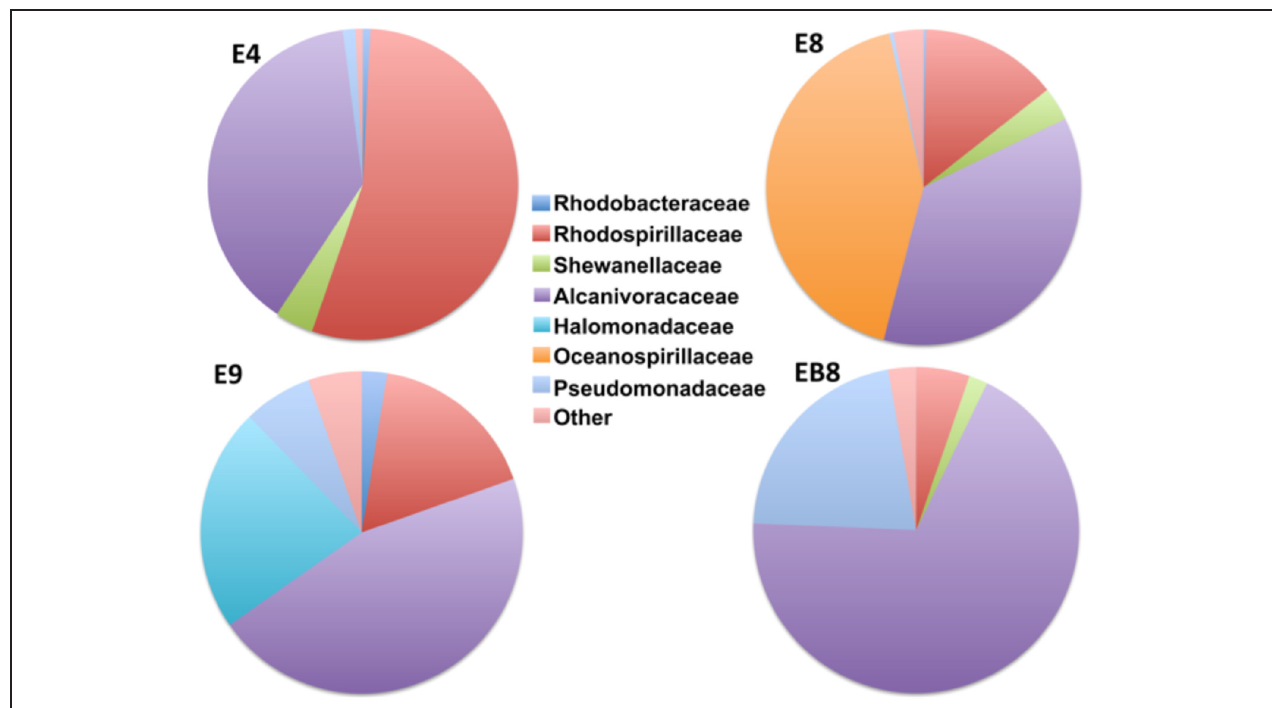
FIGURE 2 | The distribution of the bacterial Families among the screened consortia. The “Other” category stands for reads for which assignment down to family level was not possible.